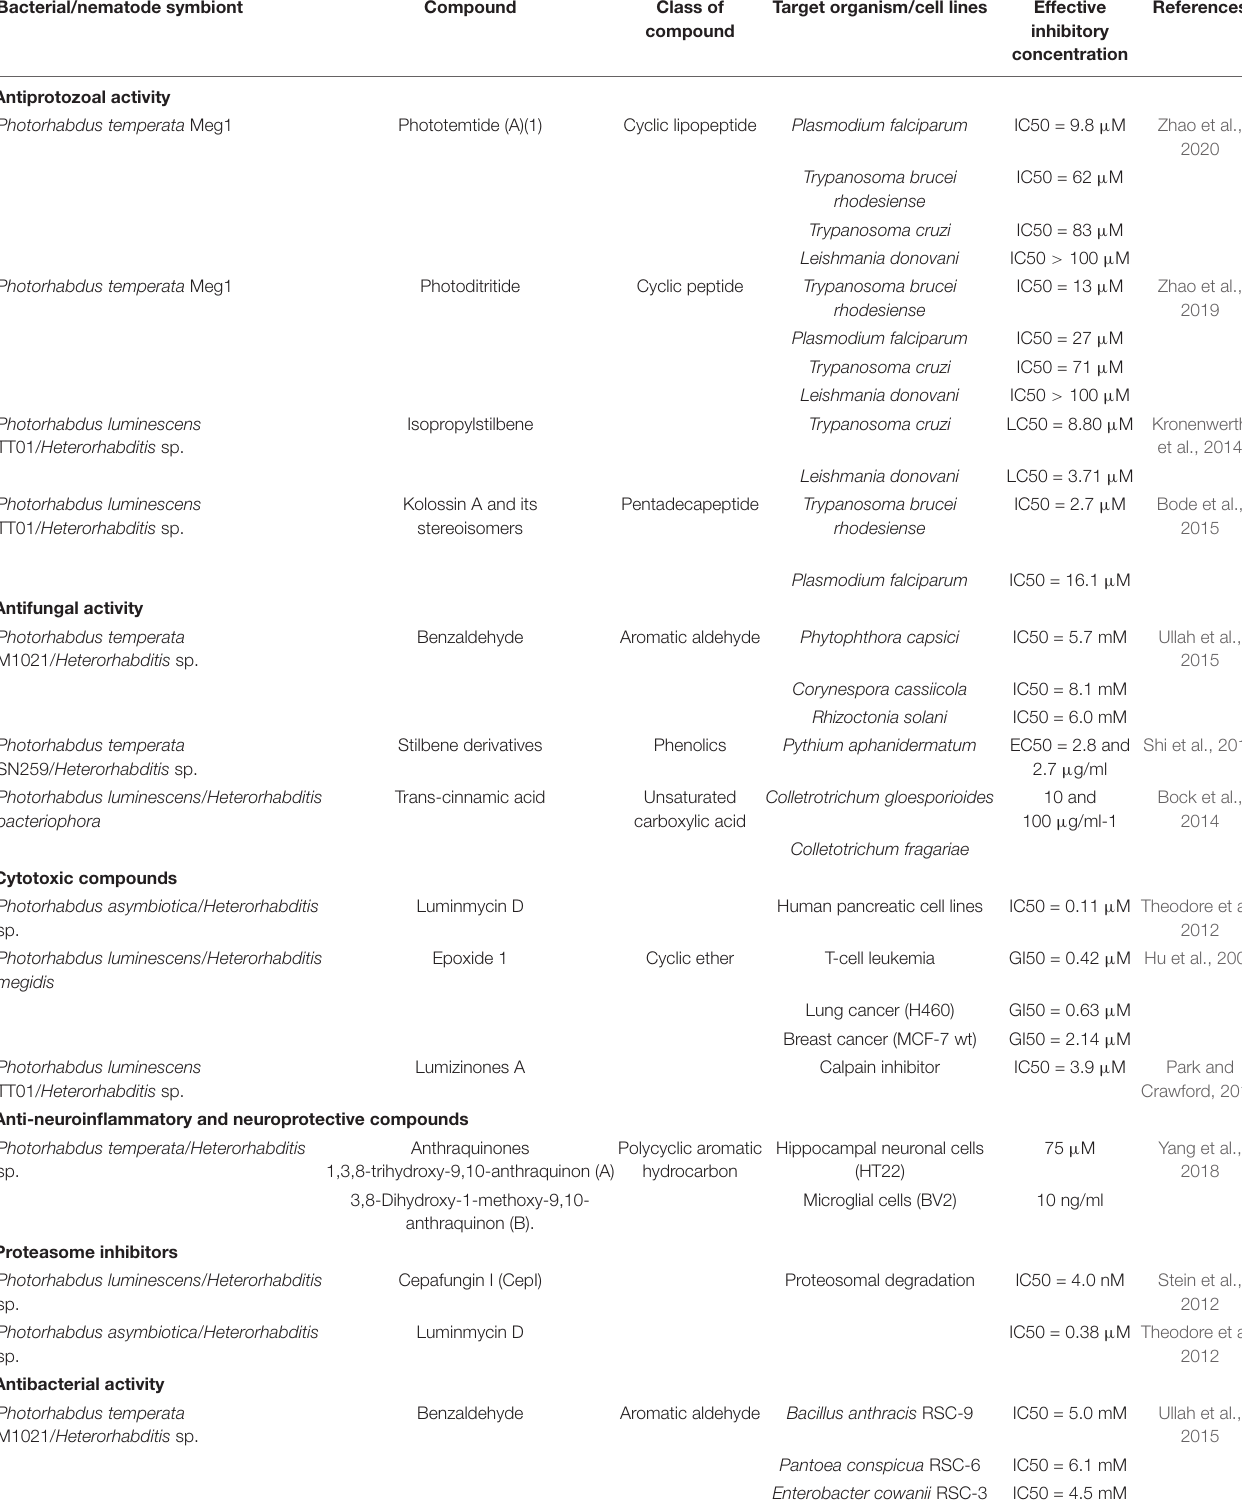
TABLE 1 | List of bioactive compounds isolated from different species of Heterorhabditis and Photorhabdus